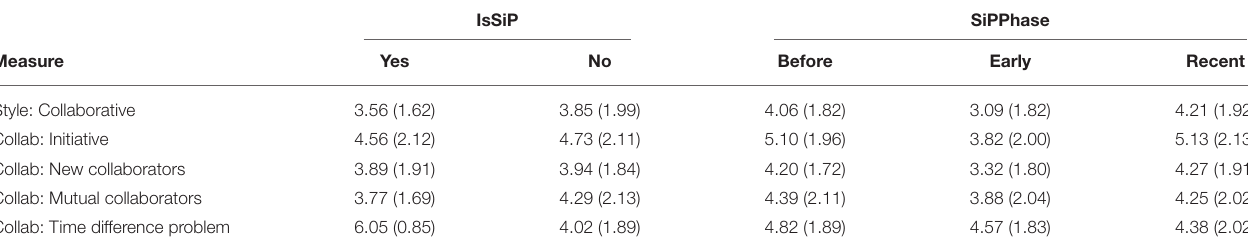
TABLE 2 | Mean and standard deviation for internet use by shelter-in-place and stage of the pandemic. Measure